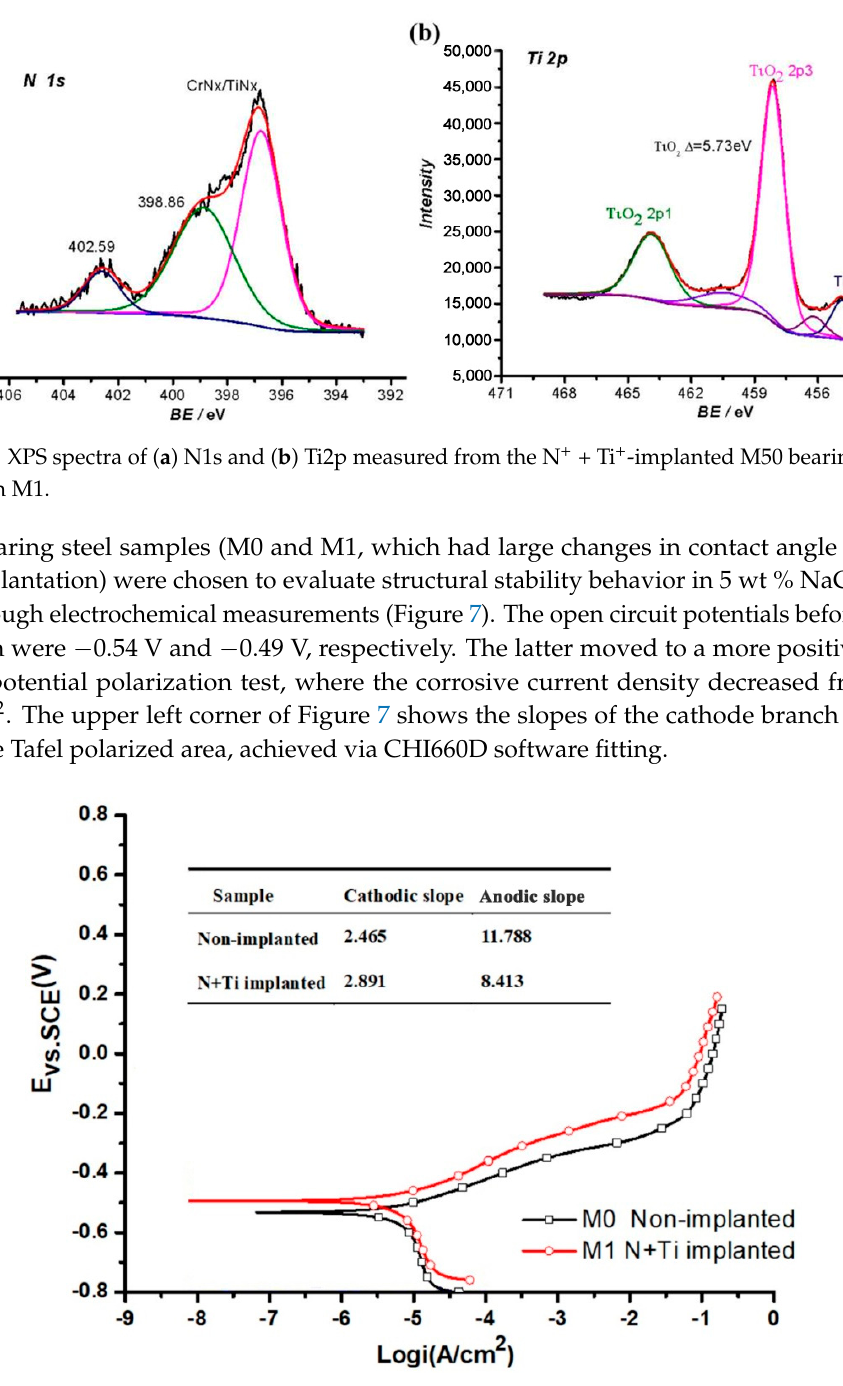
Figure 7. Potentiodynamic polarization curves measured for bare (M0) and N + + Ti + ion ‐ implanted (M1) M50 bearing steel specimens.